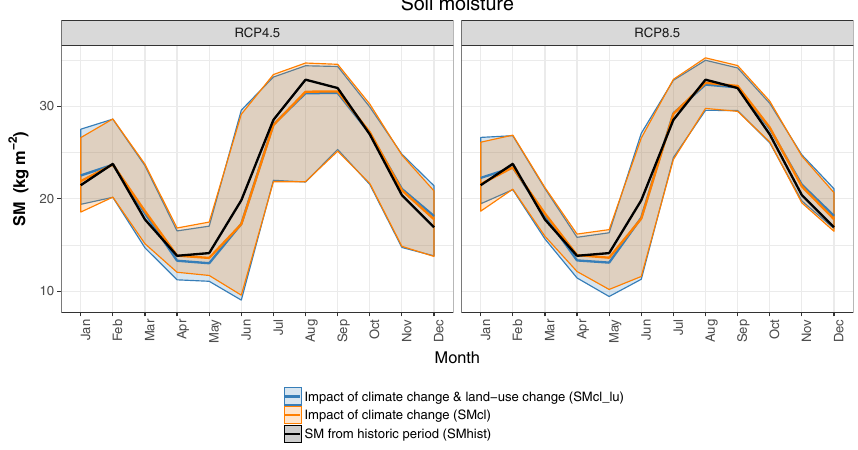
Figure 13. Multi-model mean values of the soil moisture fluxes simulated by JULES for the Upper Ganges basin and for each of the emission scenarios (RCP4.5 and RCP8.5). Black colour corresponds to the historical simulation period 2000–2005 ( SM hist ) . Orange colour corresponds to the simulation period 2030–2035, when only climate change is taken into account ( SM cl ) . Blue colour corresponds to the simulation period 2030–2035, when both climate change and land-use change are taken into account ( SM cl_lu ) . Shaded areas correspond to the maximum and minimum soil moisture values obtained from different GCM forcings and illustrate the large CMIP5 model spread.